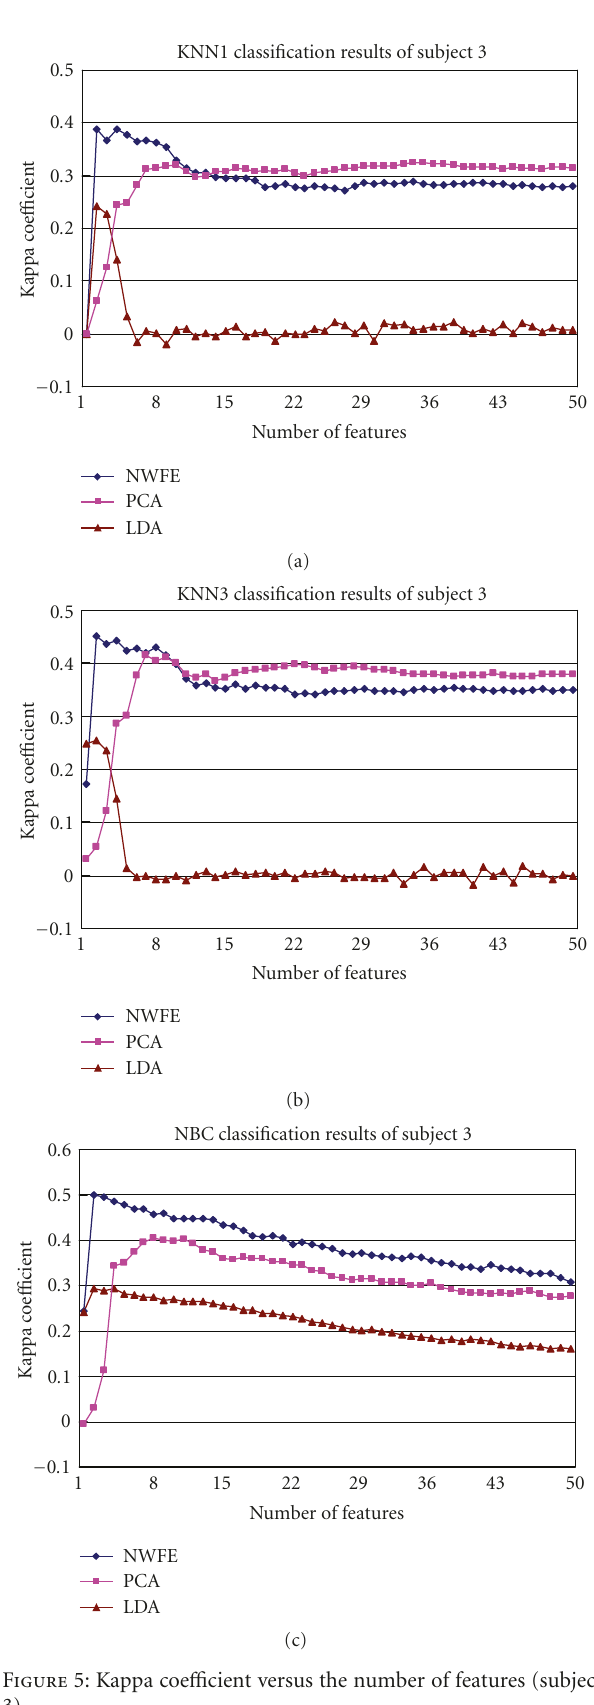
Figure 5: Kappa coe ffi cient versus the number of features (subject